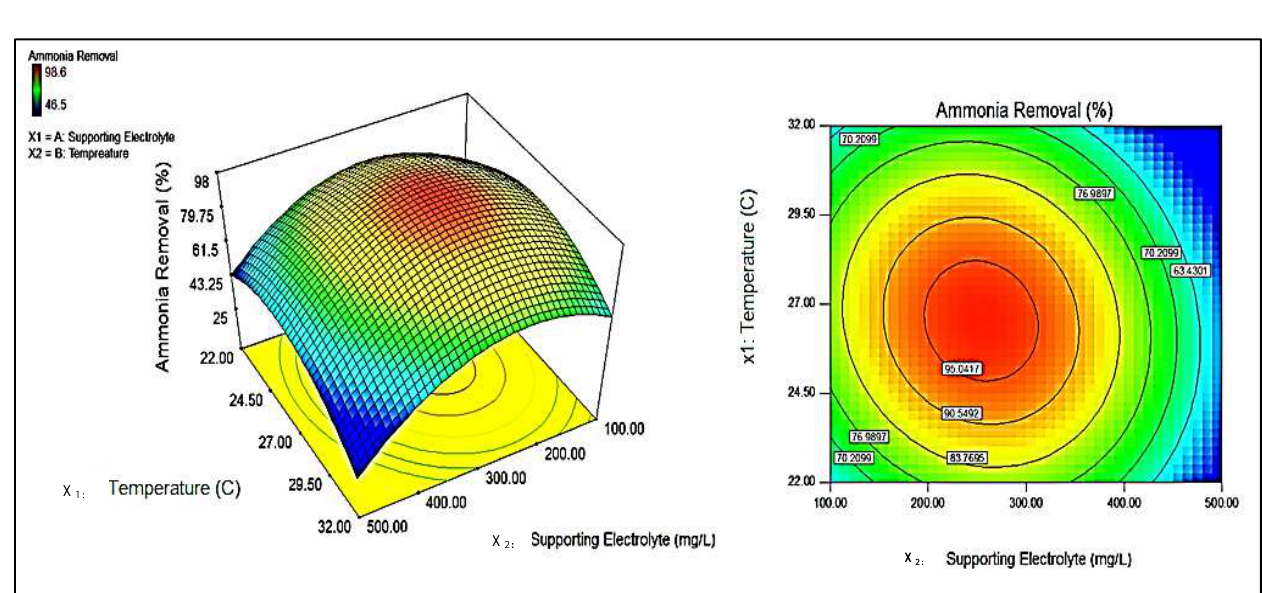
Figure 5. Three-dimensional and related contour graphics of response surface for bioelectrochemical ammonium